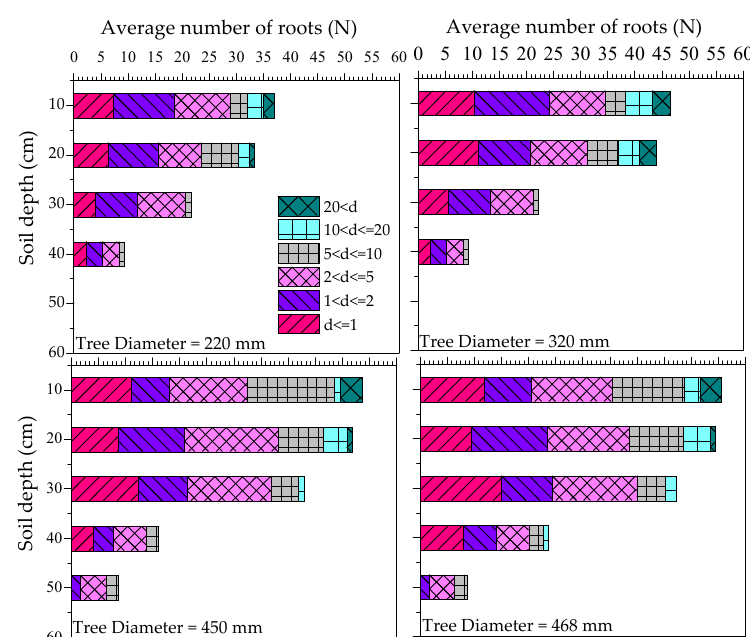
Figure 5. Root distribution with depth (d = root diameter in mm).